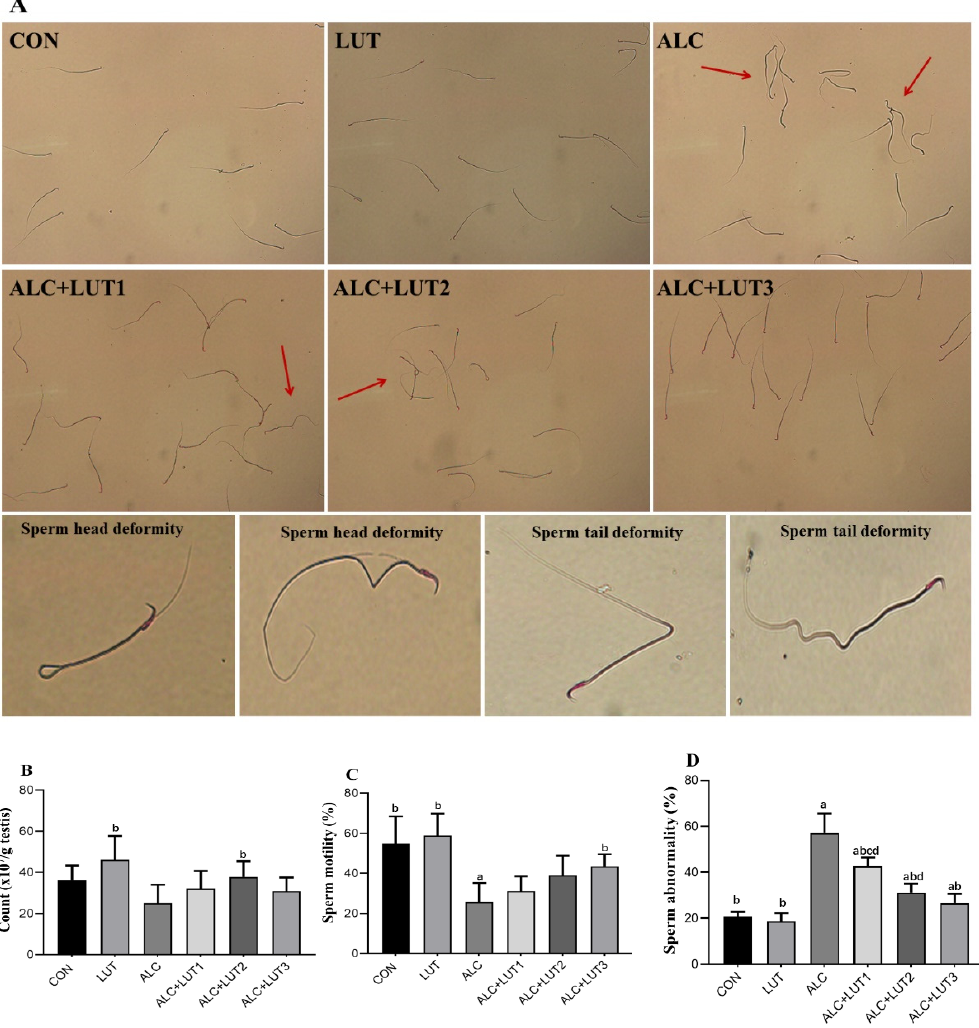
Figure 2. Effect of lutein on sperm quality in alcohol-treated rats. ( A ) Sperm morphology; ( B ) sperm count; ( C ) sperm motility; ( D ) sperm abnormality; CON: control group; LUT: Lutein alone supplement group; ALC: alcohol model group; ALC + LUT1: alcohol + low-dose lutein group; ALC + LUT2: alcohol + medium-dose lutein group; ALC + LUT3: alcohol + high-dose lutein group; The red arrow is the malformed sperm; a, vs. the control group, p < 0.05 (CON); b, vs. the alcohol group, p < 0.05 (ALC); c, vs. the ALC + LUT2 group, p < 0.05, d, vs. the ALC + LUT3 group, p < 0.05 (n = 10, mean ± SD).